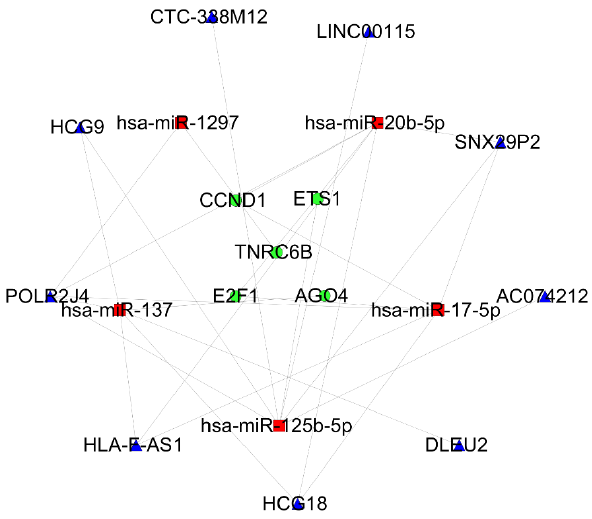
Figure 5. The hub-genes associated with the ceRNA network in a cSCC. MRNAs, miRNAs and lncRNAs are indicated by the circle in green, rectangle in red and triangle in blue, respectively.